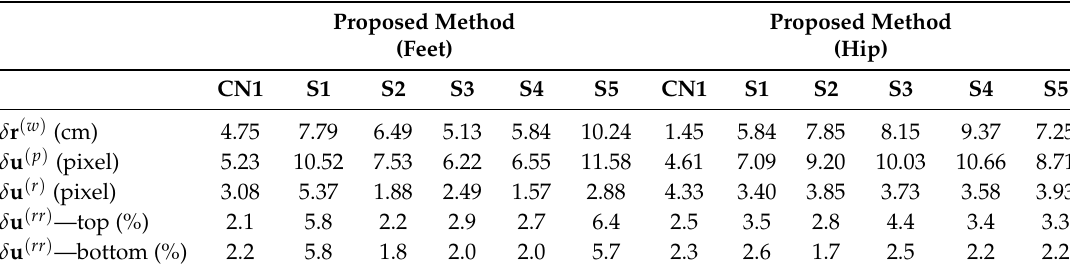
Table 9. Calibration results of camera calibration based on multiple walking people of the Camera Network 1 and the Camera Network 4. Note that, for Camera Network 1, we also apply the refinement method which proposed in [14] to obtain the final extrinsic parameters. δ r ( w ) , δ u ( p ) , δ u ( r ) , and δ u ( rr ) denotes the triangulation error, projection error, reprojection error, and relative reprojection error,